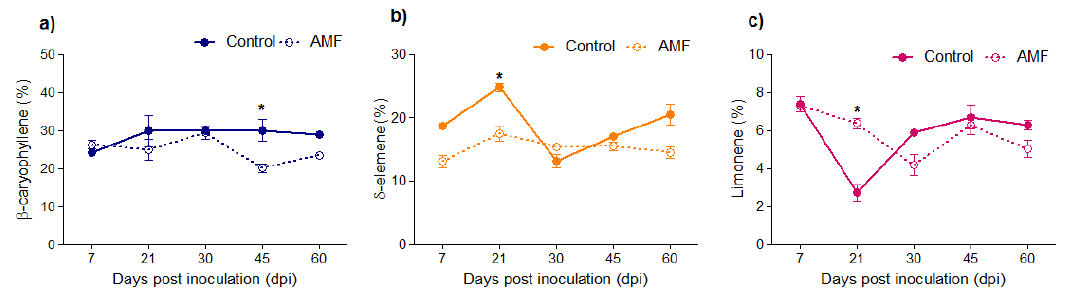
Figure 3. Variation of the main volatile compounds of roots of Piper nigrum in association with arbuscular mycorrhizal fungi. ( a ) β -caryophyllene; ( b ) δ -elemene; ( c ) limonene. Asterisks on the bars represent statistically significant differences between the treatment and control groups, at the 5% probability level, by Bonferroni.